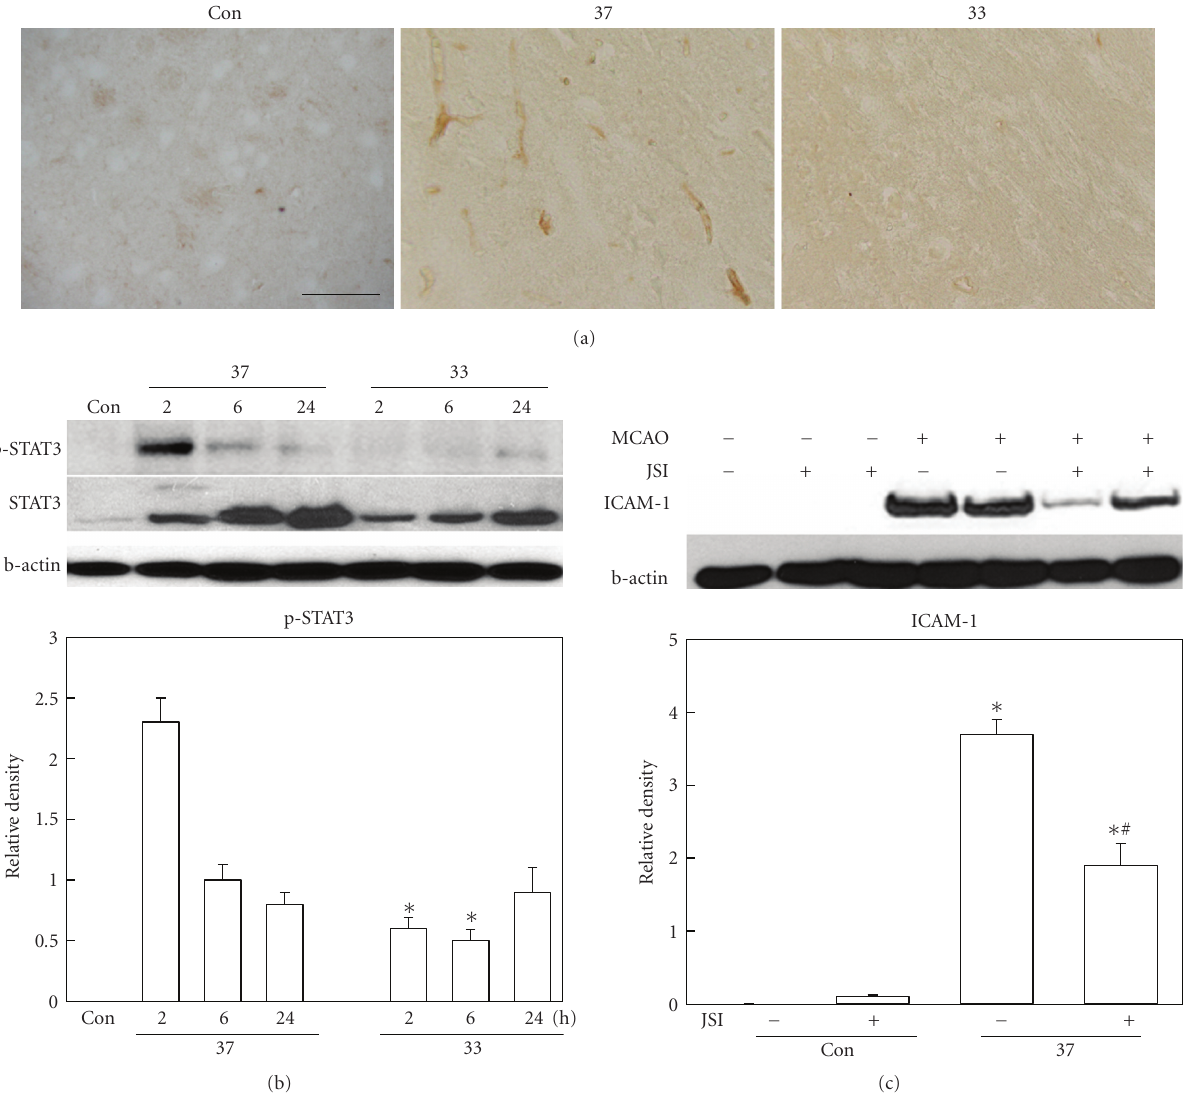
Figure 3: (a) STAT3 phosphorylation in the cerebral cortex of the ischemic brain. Photomicrograph illustrates the presence of phosphorylated STAT3 in the vessels of the ischemic brain at 2 hours after ischemic insult. Positive immunoreactivity is not observed in nonischemic brain (sham), and hypothermia (33) reduced the number of phosphorylated STAT3 positive cell compared with normothermic group (37). Scale bar: 100 μ m. (b) Western blot analysis shows that ischemia-induced STAT3 phosphorylation at 2 and 6 hours after MCAO onset in normothermic brain (37, n = 6) is reduced in hypothermia group (33, n = 6). ∗ P < . 05 versus normothermia. (c) Western blot analysis demonstrates that ICAM-1 induction at 24 hours after MCAO is reduced by STAT3 inhibitor treatment (JSI, n = 4). ∗ P < . 05 versus sham; # P < . 05 versus ischemia without